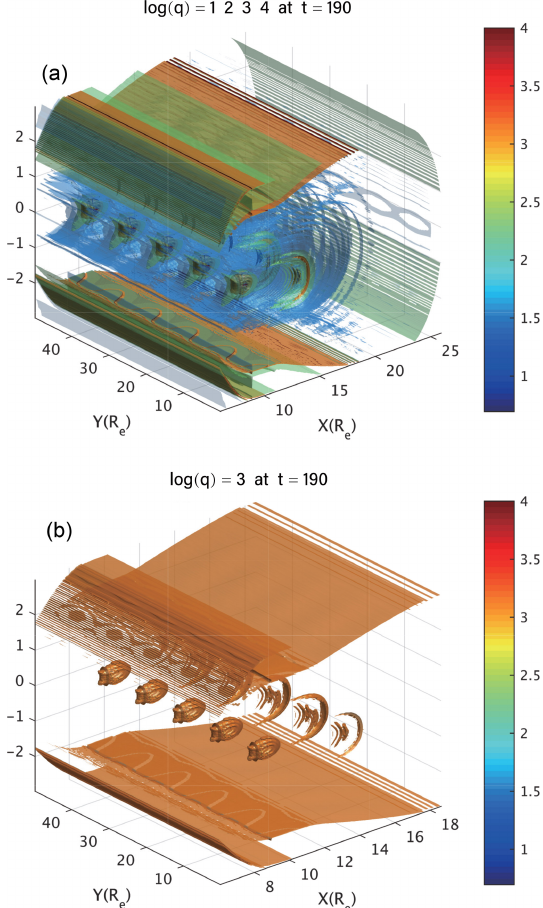
Figure 7. Iso-surfaces of the logarithm of squashing degree in the broader 3-D domains, which include two periods of repeating QSL distribution from x = 9 . 5, y = 15, z = 0 to x = 9 . 5, y = 25, z = 0 (a) and from x = 13 . 4, y = 10, z = 0 to x = 13 . 4, y = 20, z = 0 (b) , respectively, at t = 190.